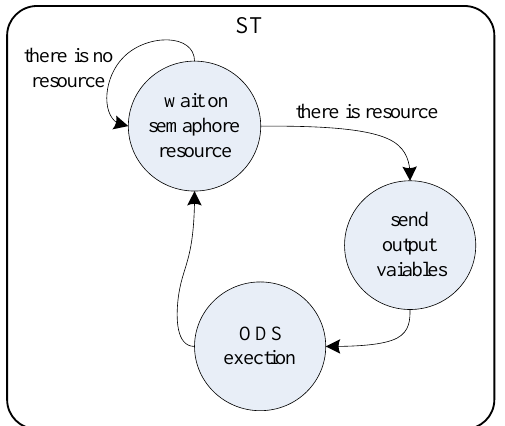
Figure 5. Finite automata associated with